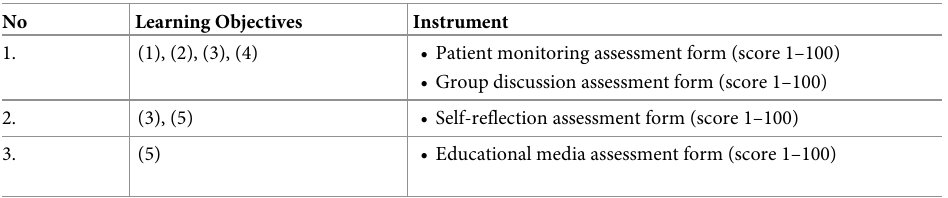
Table 2. Standard evaluation instruments for student’s